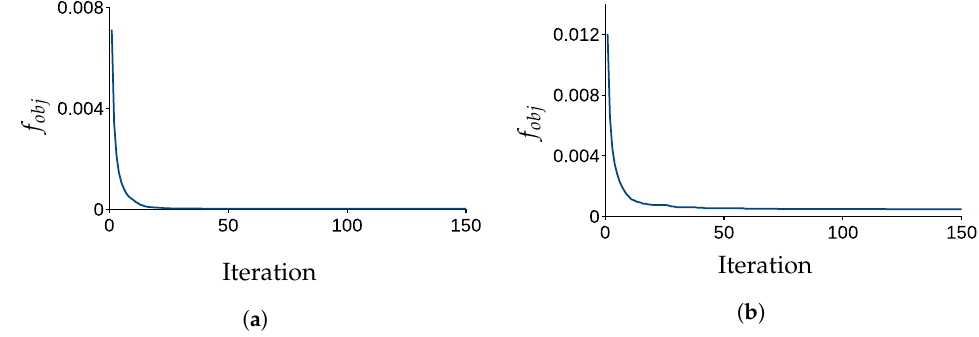
Figure 4. f obj in each iteration for PSO. ( a ) Hip; and ( b ) Knee.